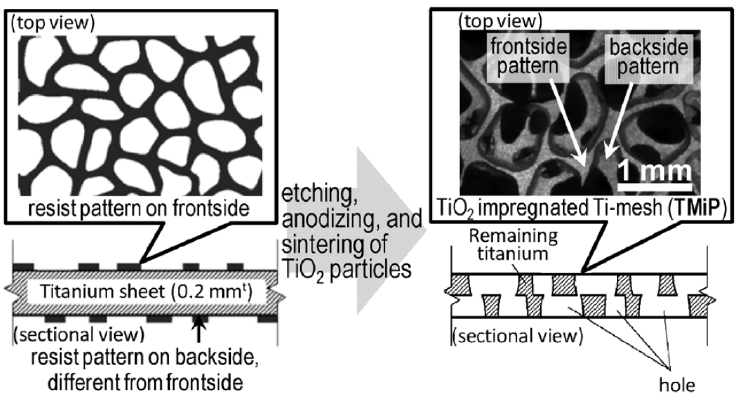
Figure 9. Production of a titania nanoparticles impregnated mesh filter via etching, anodization, dip coating, and sintering. (Reprinted/adapted with permission from Ref.